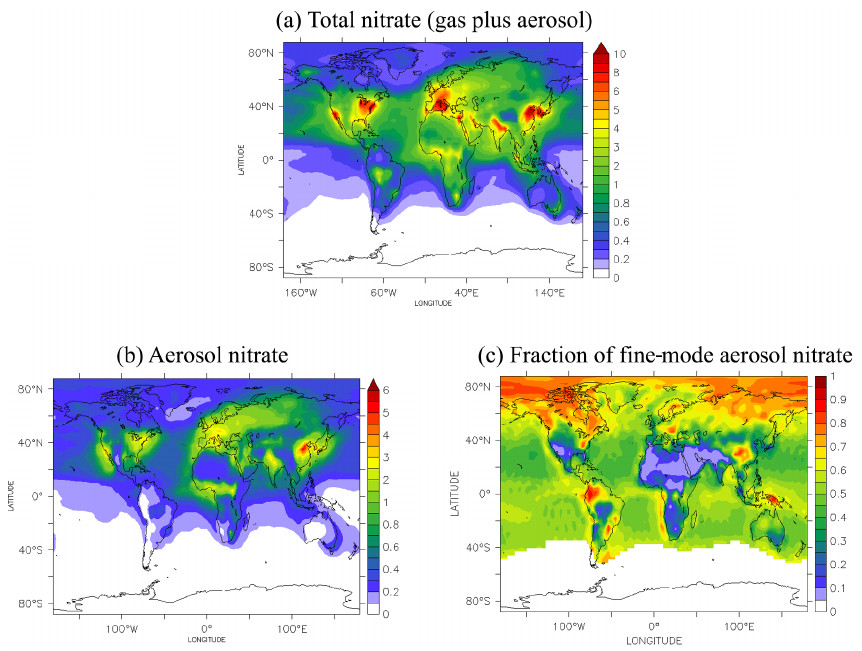
Figure 3. Predicted average near-surface concentrations (in µgm − 3 ) of (a) total nitrate (sum of gas and aerosol phases), (b) aerosol nitrate, and (c) fraction of fine-mode aerosol nitrate to total aerosol nitrate during the years 2005–2008.